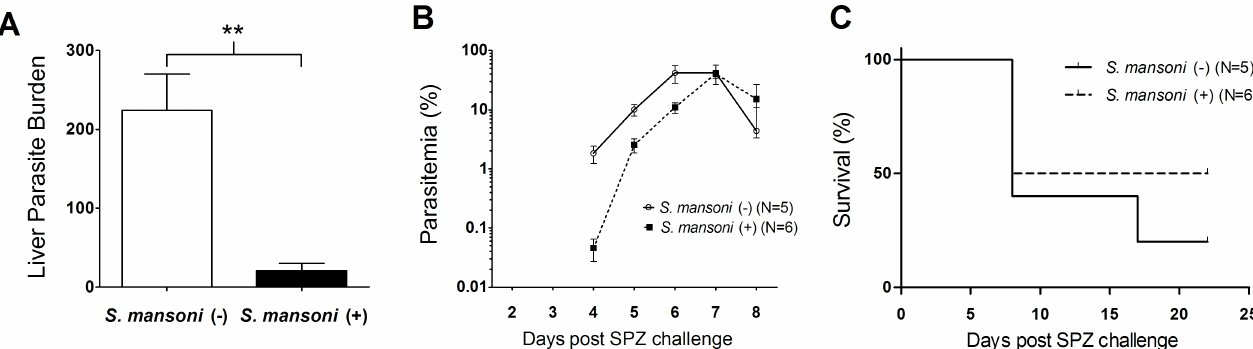
Fig 1. Growth of malaria parasites in the liver and blood of mice following SPZ inoculation of Plasmodium yoelii with and without Schistosoma mansoni infection. (A) Copy number of P . yoelii 18s RNA gene per 1 × 10 6 mouse G3PDH gene measured at 42 h post SPZ inoculation. Female BALB/c mice (N = 6) infected with 50 S . mansoni -cercariae 10 weeks previously were challenged with 1,500 P . yoelii SPZ along with S . mansoni -non-infected controls. (cid:3)(cid:3) P < 0.01, Student’s two-tailed t-test, t = 4.362, df = 10. (B) Parasitaemia. Blood stage malaria parasites were monitored daily from day 2 to 8 post i.v. inoculation of 500 P . yoelii SPZ. (C) Percentage survival. Data from one representative experiment of three independent repeats are shown.